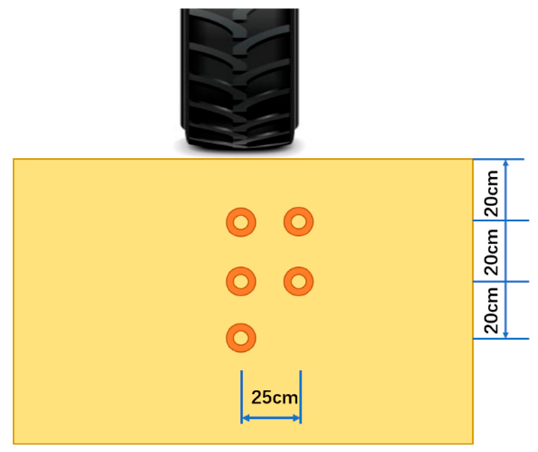
Figure 5. The locations of the soil sample collection to measure the soil bulk density in vertical (3 locations) and lateral (2 locations)